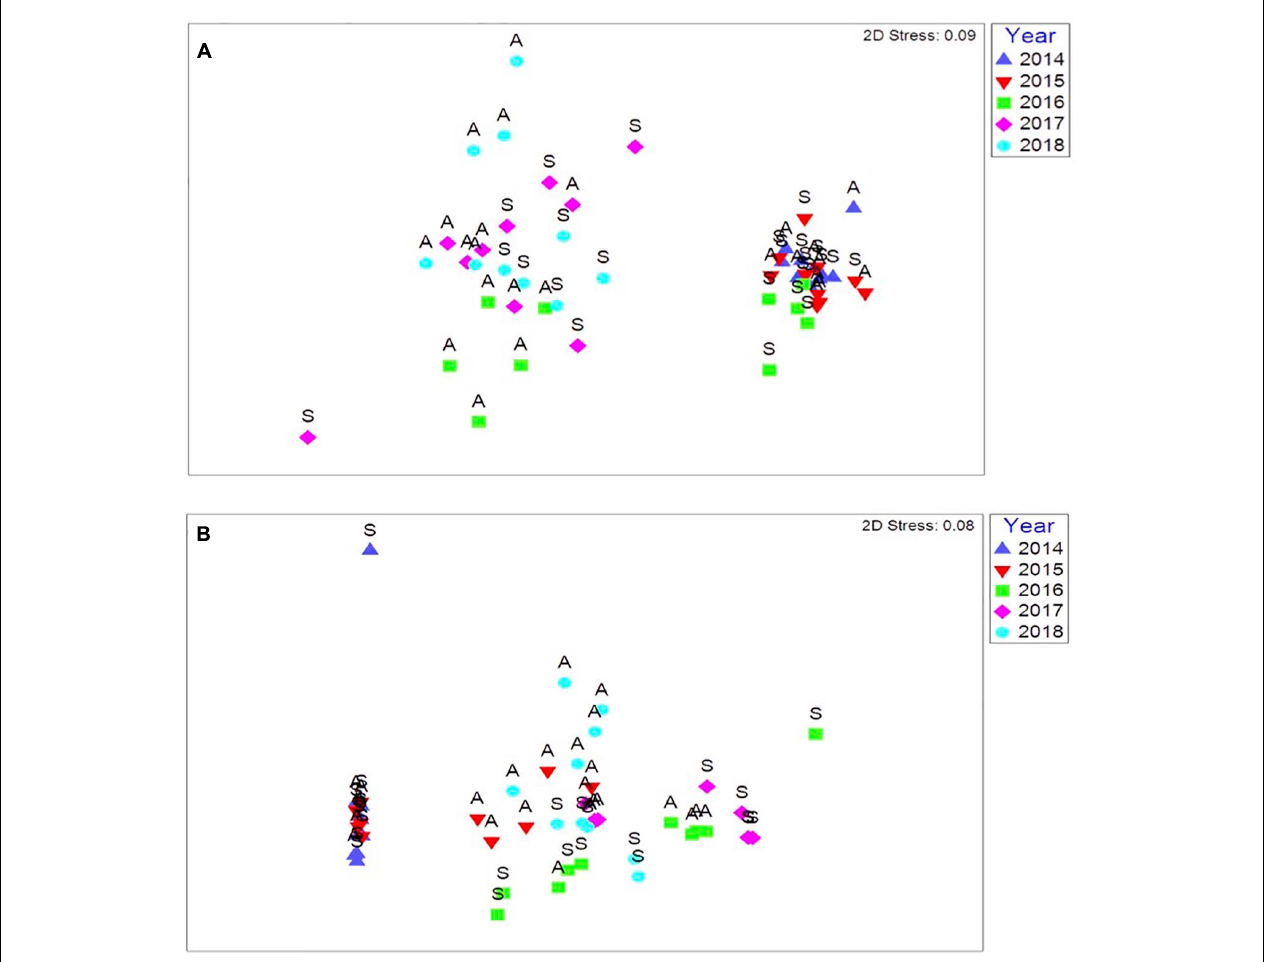
FIGURE 9 | (A) Multi-dimensional scaling ordination of communities diversity per season (S, Spring; A, Autumn) from immediately after the storm events in spring 2014 until autumn 2018 in the low eulittoral at Trevone, (B) MDS plot showing communities diversity per season (S, Spring; A, Autumn) from immediately after the storm events in spring 2014 until autumn 2018 in the mid eulittoral at Trevone. Based on Bray Curtis similarity coefficient, non-standardised data and square root transformed